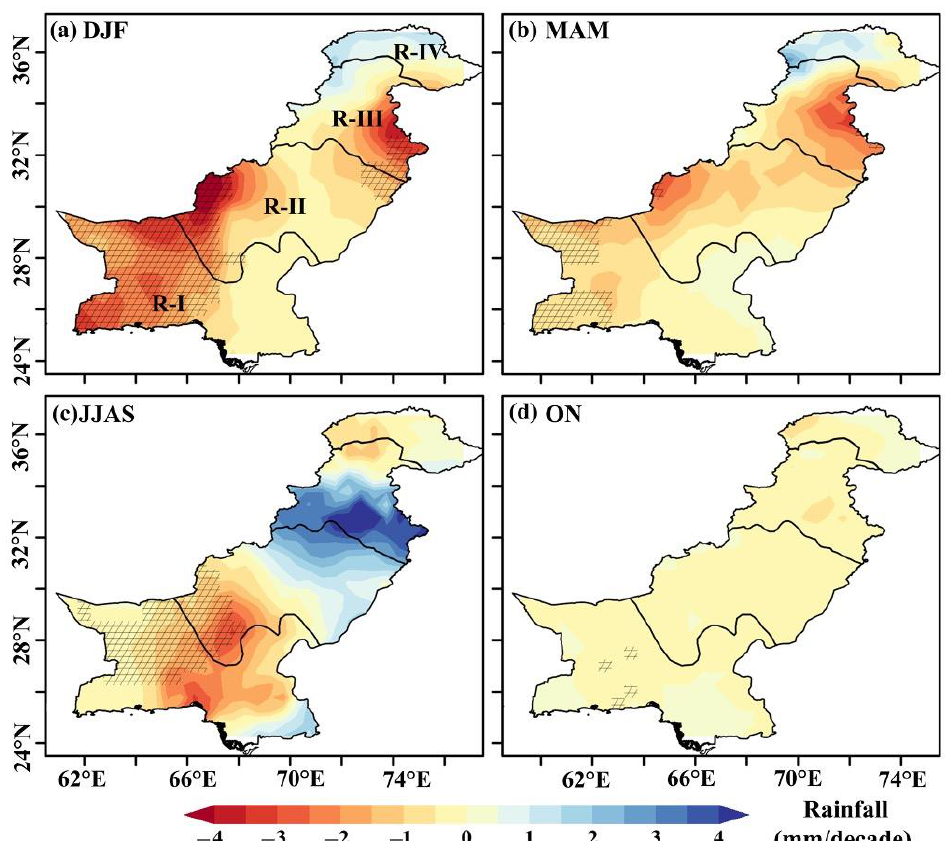
Figure 7. Spatial distribution of Mann–Kendal trend (mm/decade) of rainfall during the ( a ) DJF (December to February), ( b ) MAM (March to May), ( c ) JJAS (June to September), and ( d ) ON (October to November) Season over the China Pakistan Economic Corridor for 1980-2018. The hatched area shows a statistically significant trend at a 90% confidence level. R-I, R-II, R-III, and R-IV represent the hyper-arid, arid, humid, and glacial regions, respectively.